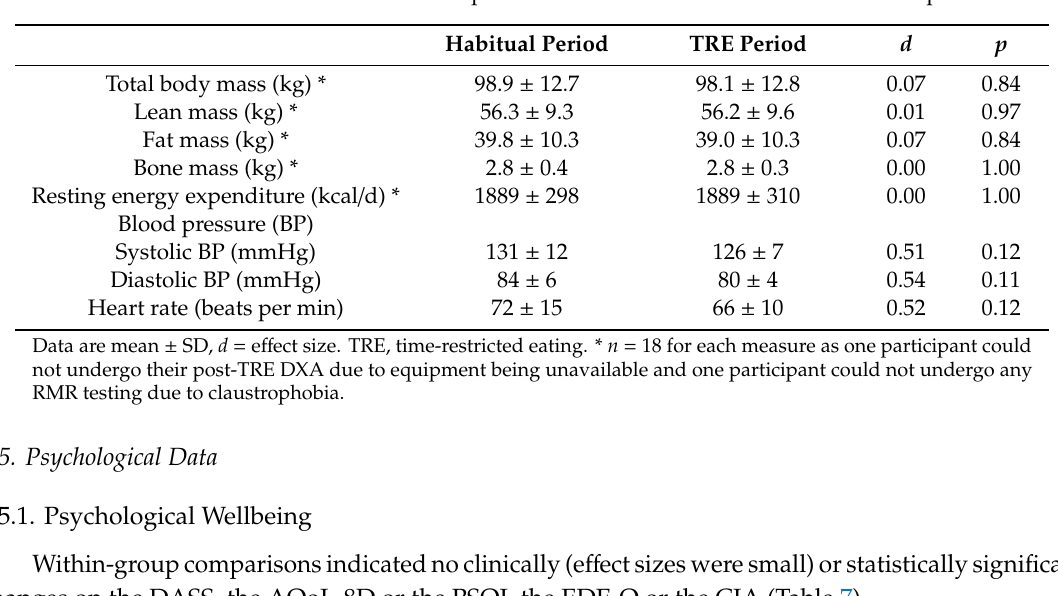
Table 6. Overview of physiological variables of individuals with type 2 diabetes and overweight / obesity measured at the end of the 2-week Habitual period and after the 4-week TRE intervention period.